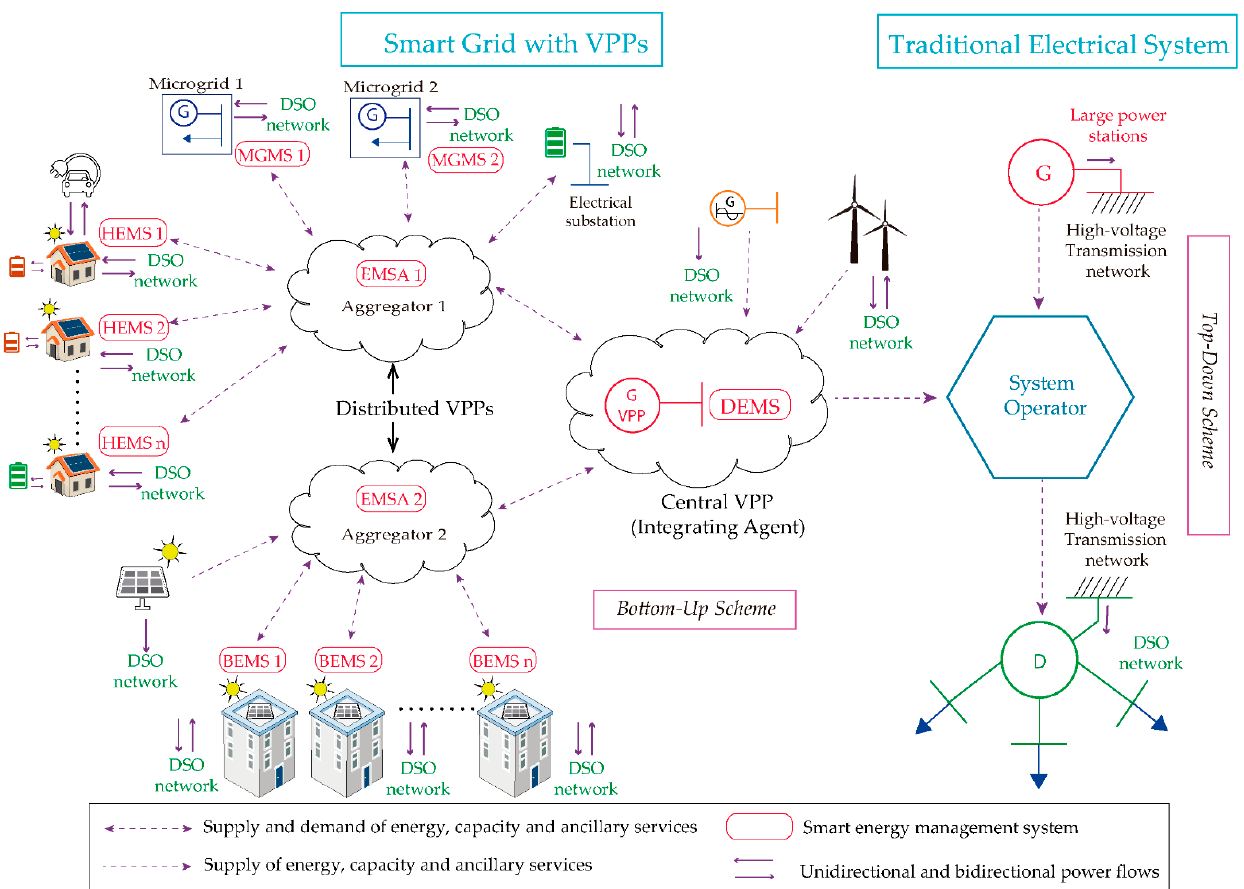
Figure 5 . DERs bottom-up management through DEMS, distributed VPPs and central VPP . Figure 5. DERs bottom-up management through DEMS, distributed VPPs and central